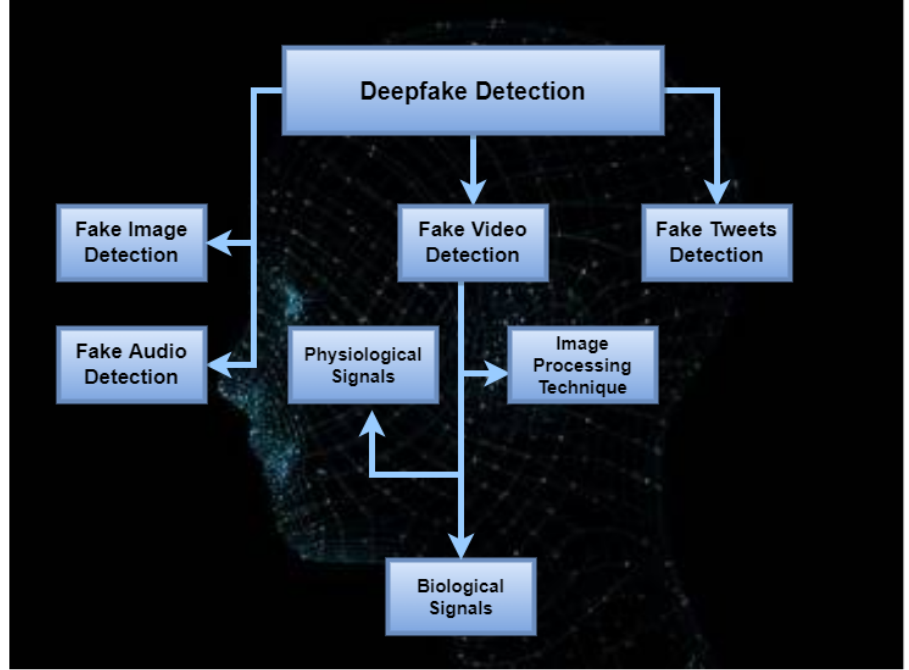
Figure 7. Types of deepfake videos and detection